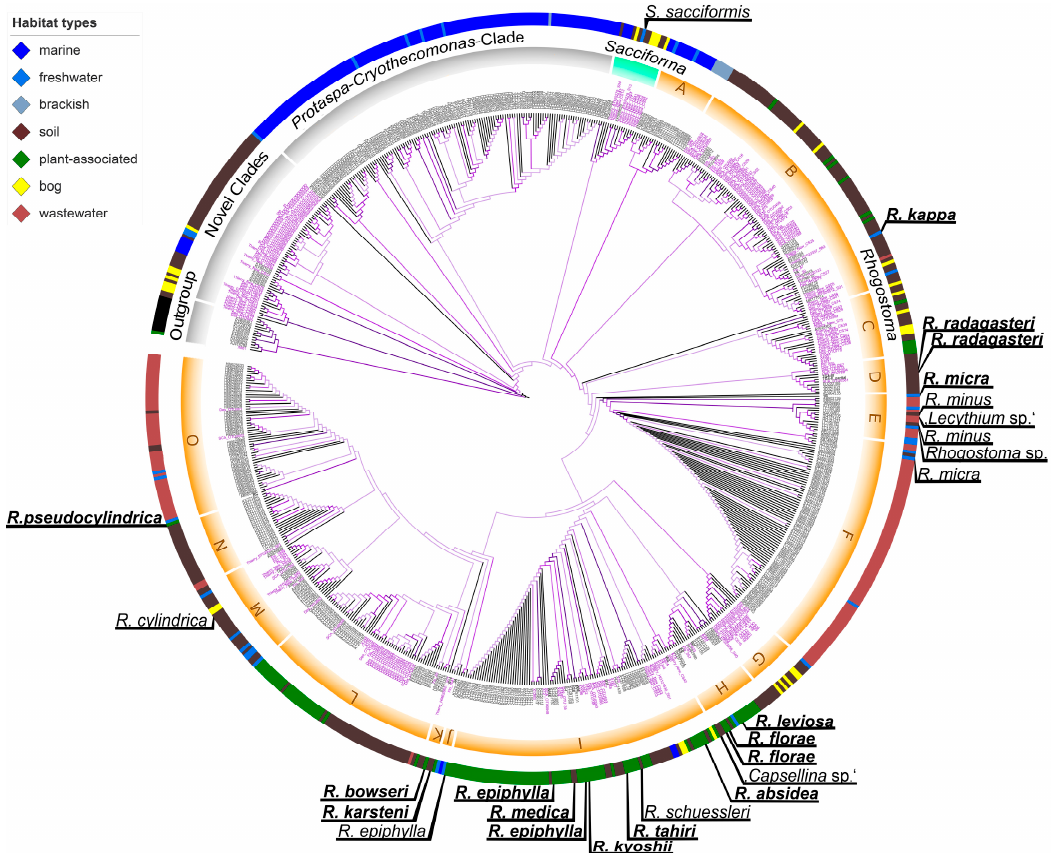
Figure 4. SSU rDNA phylogeny of Cryomonadida (Rhogostomidae and relatives) with a focus on Rhogostomidae diversity (highlighted in orange for Rhogostoma and cyan for Sacciforma) with chosen Tectofilosida as outgroup. Shown is the maximum likelihood tree obtained by RAxML. The bootstrap values are visualized in a colour flow from black (low support) to purple (high support); end nodes are also given in black. Environmental sequences of the in-depth analysed datasets [5,6,9,24,25] are indicated in purple font, NCBI database environmental sequences and sequences derived from isolated strains are indicated in black. Isolation habitats are highlighted and visualized in the outer colour stripe.